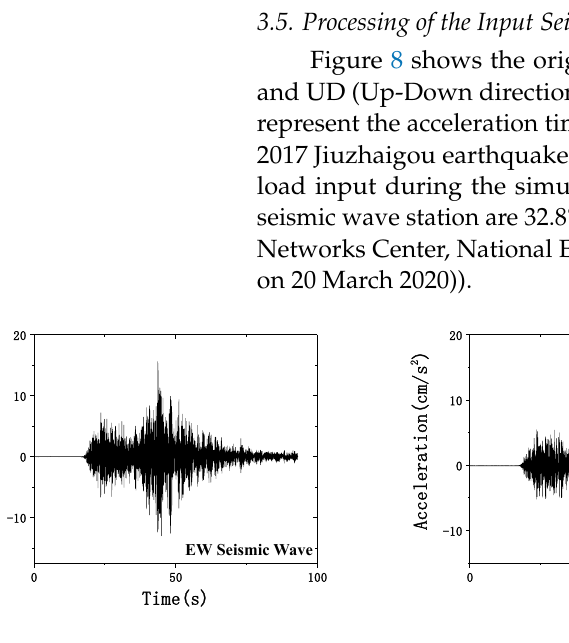
Figure 8. Ground acceleration records of Jiuzhaigou earthquake.